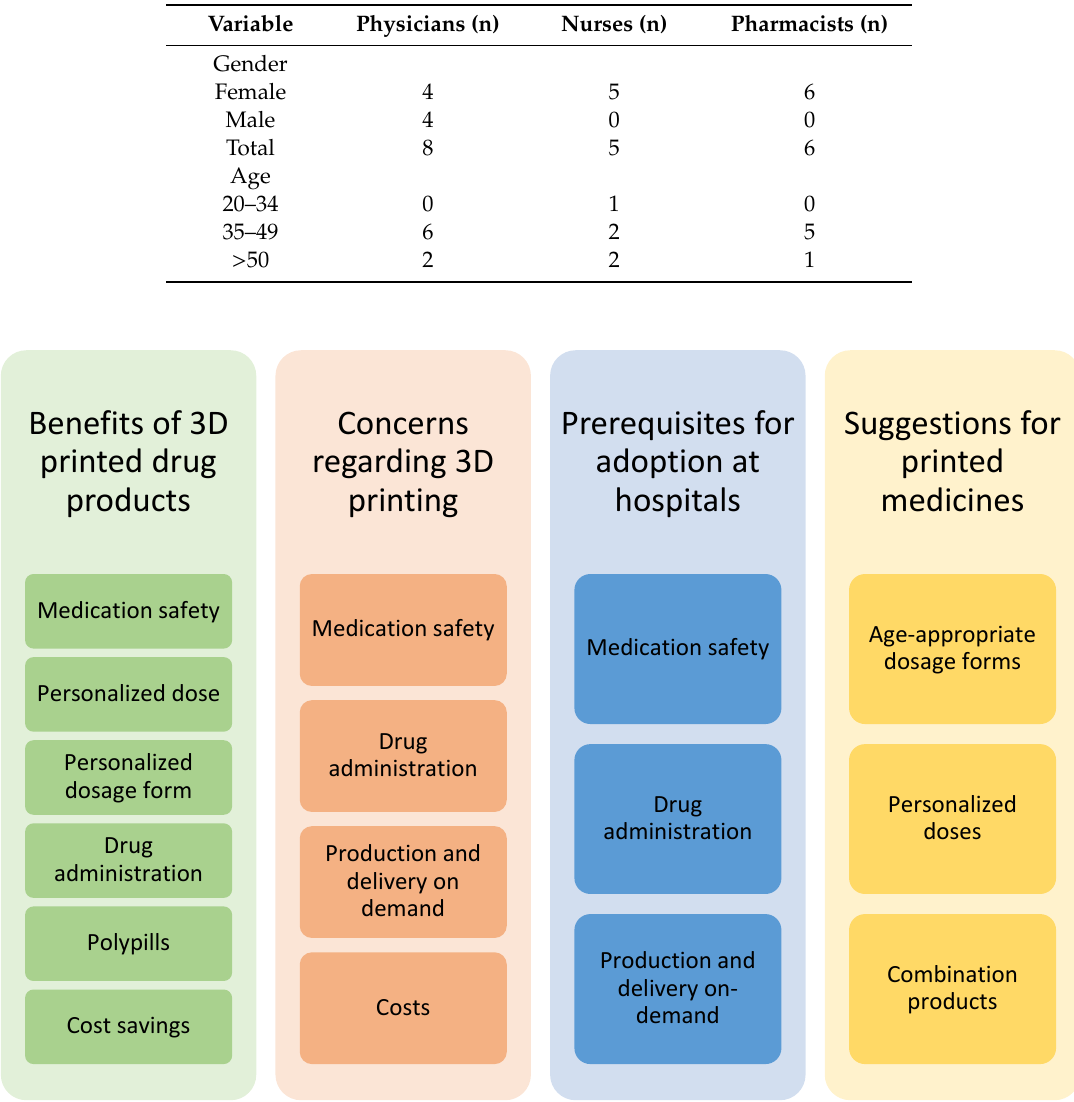
Figure 1. Themes of categories and subcategories identified in the focus group discussions of healthcare professionals on 3D-printed drug products.